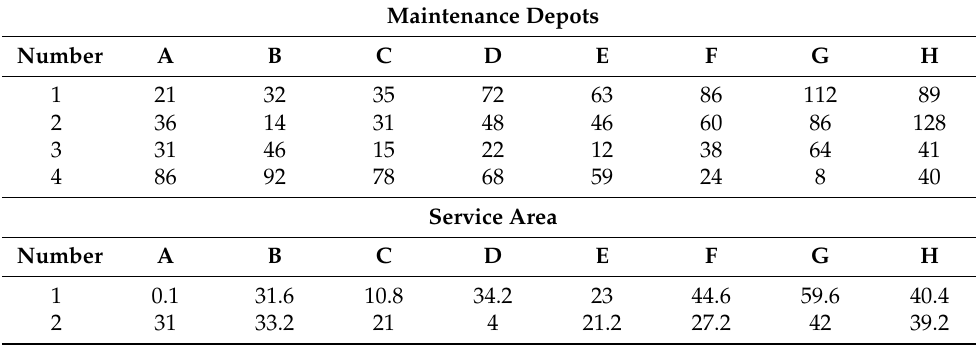
Table 2. Time weight from maintenance depots and service area to blackspots (average running time,